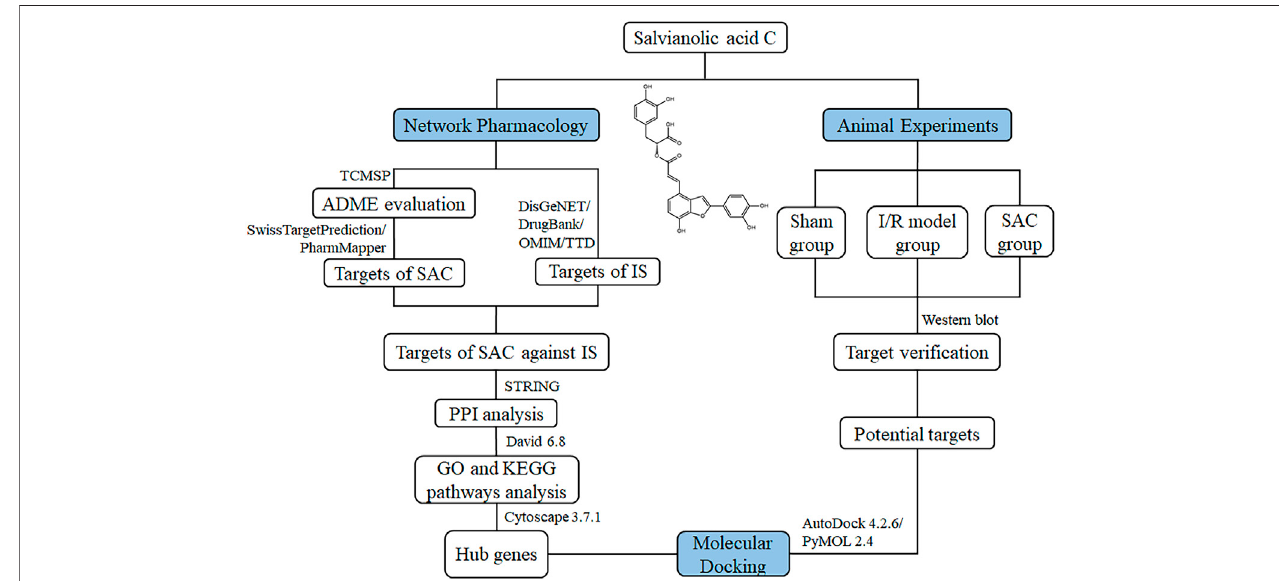
FIGURE 1 | Chemical structure of SAC and fl owchart of the mechanisms of SAC against IS.